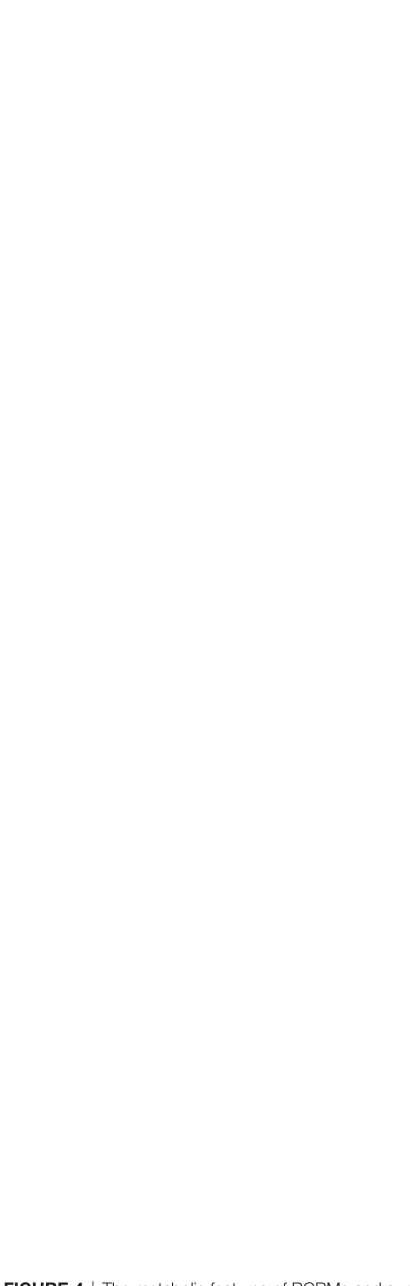
FIGURE 4 | The metabolic features of BCBMs and survival analysis. (A) Gene ontology enrichment analysis of up-regulated (red) and down regulated (blue) genes in BCBMs (n = 19) versus BCs (n = 19) (GSE43837) (P < 0.05; FDR < 0.25). MF: Molecular function, CC: Cell component, BP: Biological process. (B) KEGG enrichment analysis of upregulated and down regulated gene sets in BCBMs (n = 19) versus BCs (n = 19) (GSE43837) (P < 0.05; FDR < 0.25). (C) GSEA analysis demonstrating all KEGG metabolism signi fi cantly altered (p < 0.05, FDR < 0.25) in BCBMs (n = 19) versus BCs (n = 19) (GSE43837). The normalized enrichment score (NES) forms the x- axis. Upregulated gene sets are shown in red. No down regulated gene sets met the criteria for statistical signi fi cance. (D) GSEA analysis enrichment plot demonstrating signi fi cant enrichment of OXPHOS gene set in BCBMs (n = 19) versus BCs (n = 19) (GSE43837). NES and FDR q are listed on the enrichment plot. (E) Venn diagram of DEGs and OXPHOS core enrichment genes obtained by GSEA. A total of 6 overlapping genes were obtained. The OXPHOS core enrichment genes obtained by GSEA are provided in Supplementary Table 6 . The 6 overlapping genes are provided in Supplementary Table 7 . (F) Bar graph showing log2(FC) values for differentially expressed OXPHOS- and immune-associated genes in BCBMs (n = 19) relative to BCs (n = 19). (G) Comparison of CPM for PGC1A RNA expression between BCBMs (n = 19) and BCs (n = 19) from GSE43837. Lines represent mean ± SD, and each dot represents a single sample. Signi fi cance was determined via Wilcoxon rank-sum test. (H) Prognostic signi fi cances of OP-metagene in patients with breast cancer were shown based on the KM plotter database. RFS, relapse ‐ free survival; OS, overall survival; DMFS, distance metastasis free survival; and HR, hazard ratio. The P values were determined using a log-rank test. (I) Prognostic signi fi cances of OP-metagene in patients with various breast cancer subtypes were shown based on the KM plotter